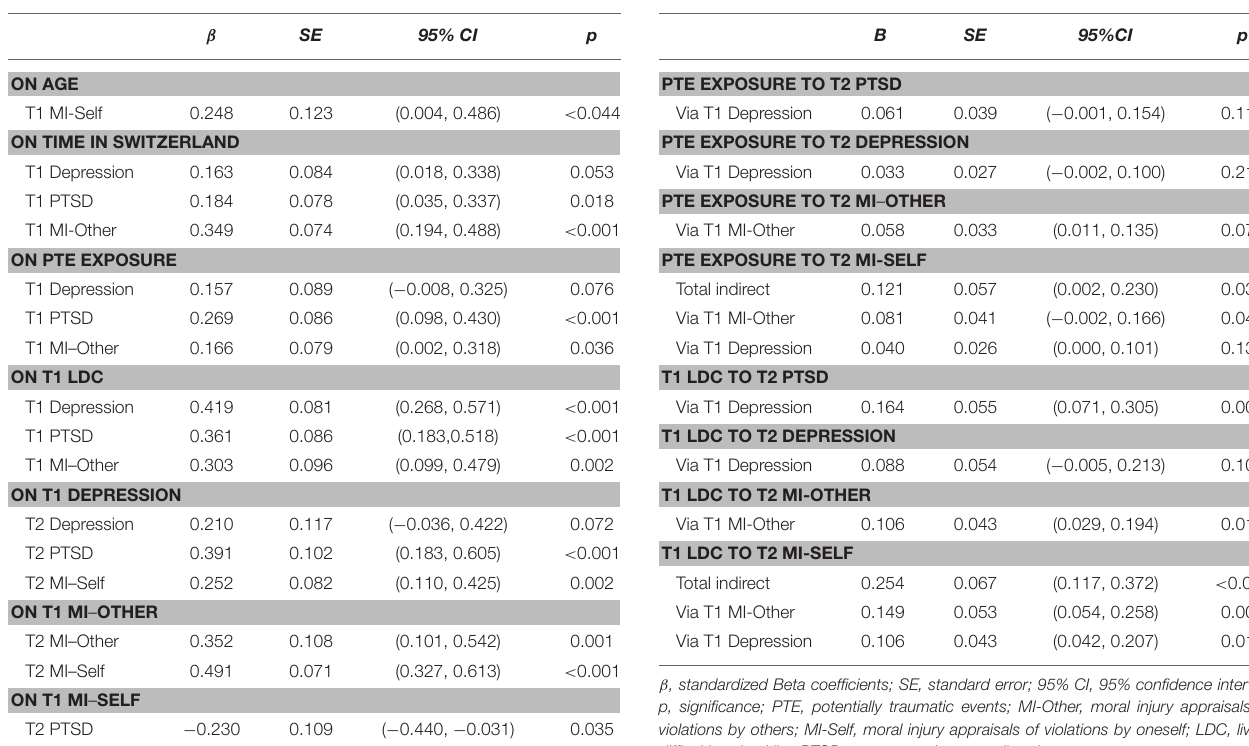
TABLE 2 | Standardized coefficients for direct effects in path model. TABLE 3 | Standardized indirect effects for path